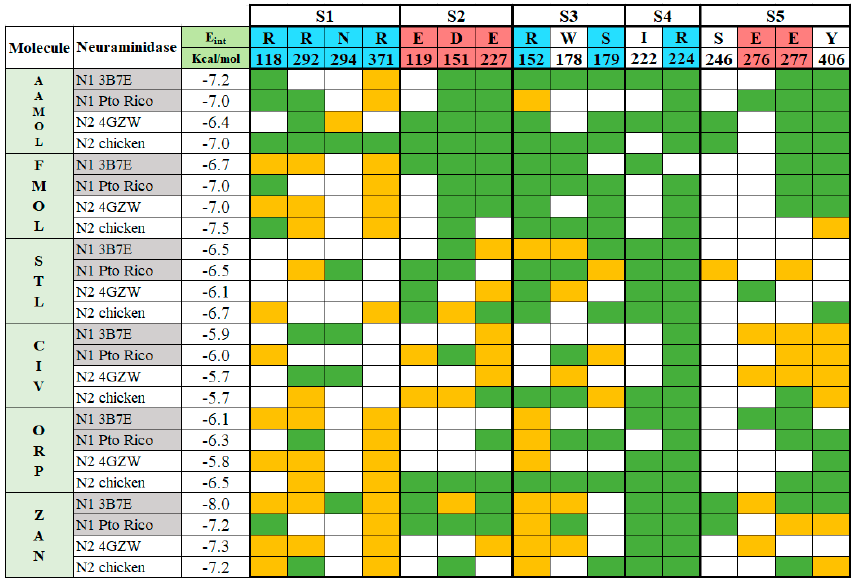
Figure 4. Binding pattern between the ligands AAMOL, FMOL, STL, CIV, ORP or zanamivir and the interacting amino acids of group 1 and 2 neuraminidases. The active site was subdivided into five subsites for inspection. Color code of the table cells: blue or red for positively or negatively charged interacting residues, respectively; yellow for hydrogen bonds; and green for hydrophobic contacts.